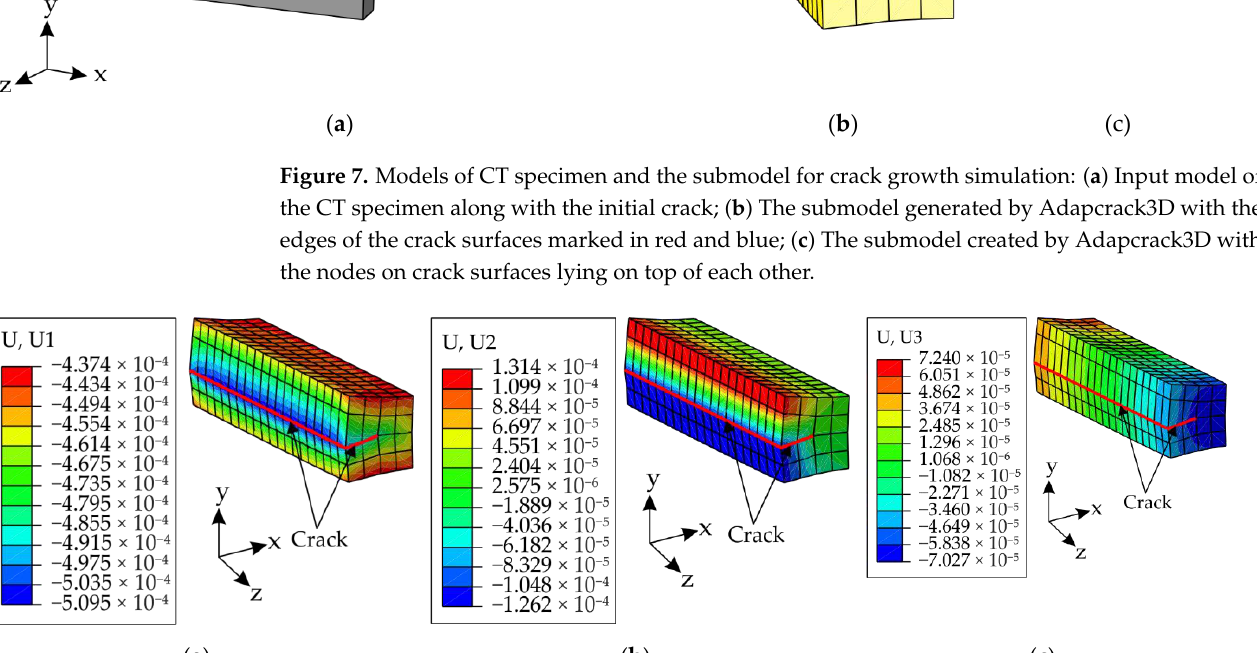
Figure 7. Models of CT specimen and the submodel for crack growth simulation: ( a ) Input model of the CT specimen along with the initial crack; ( b ) The submodel generated by Adapcrack3D with the edges of the crack surfaces marked in red and blue; ( c ) The submodel created by Adapcrack3D with the nodes on crack surfaces lying on top of each other.